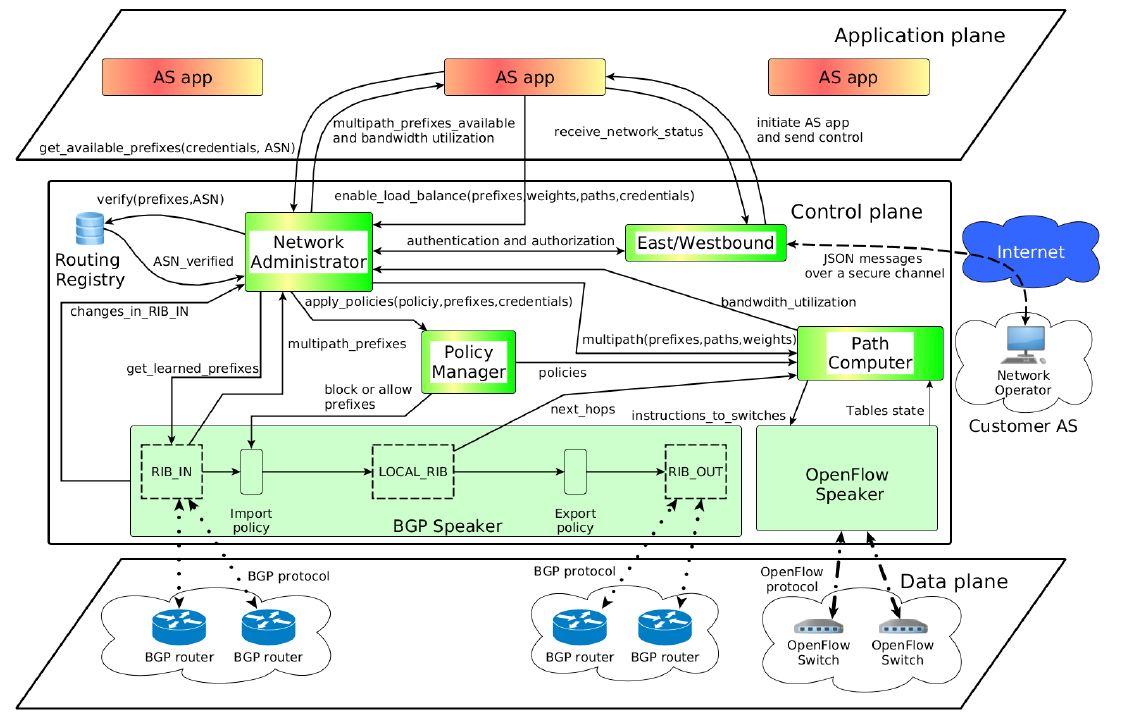
Figure 3. The proposed architecture described by the application, control, and data planes of SDN